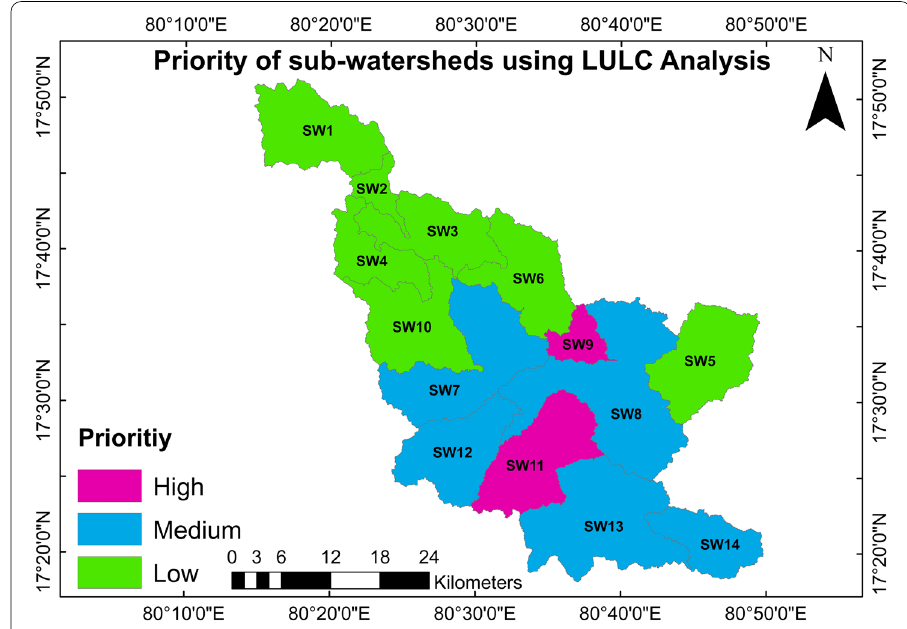
Fig. 10 Priority of sub-watersheds based on LULC